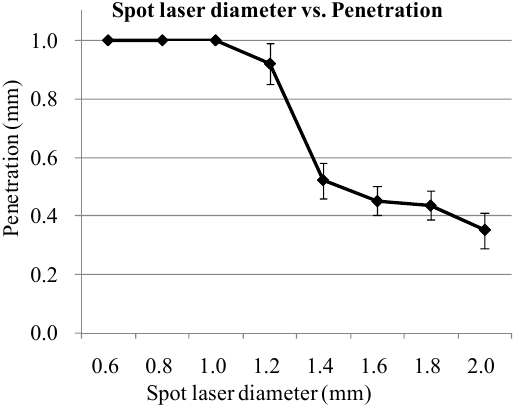
Figure 12. Effects of spot laser diameter on weld penetration.